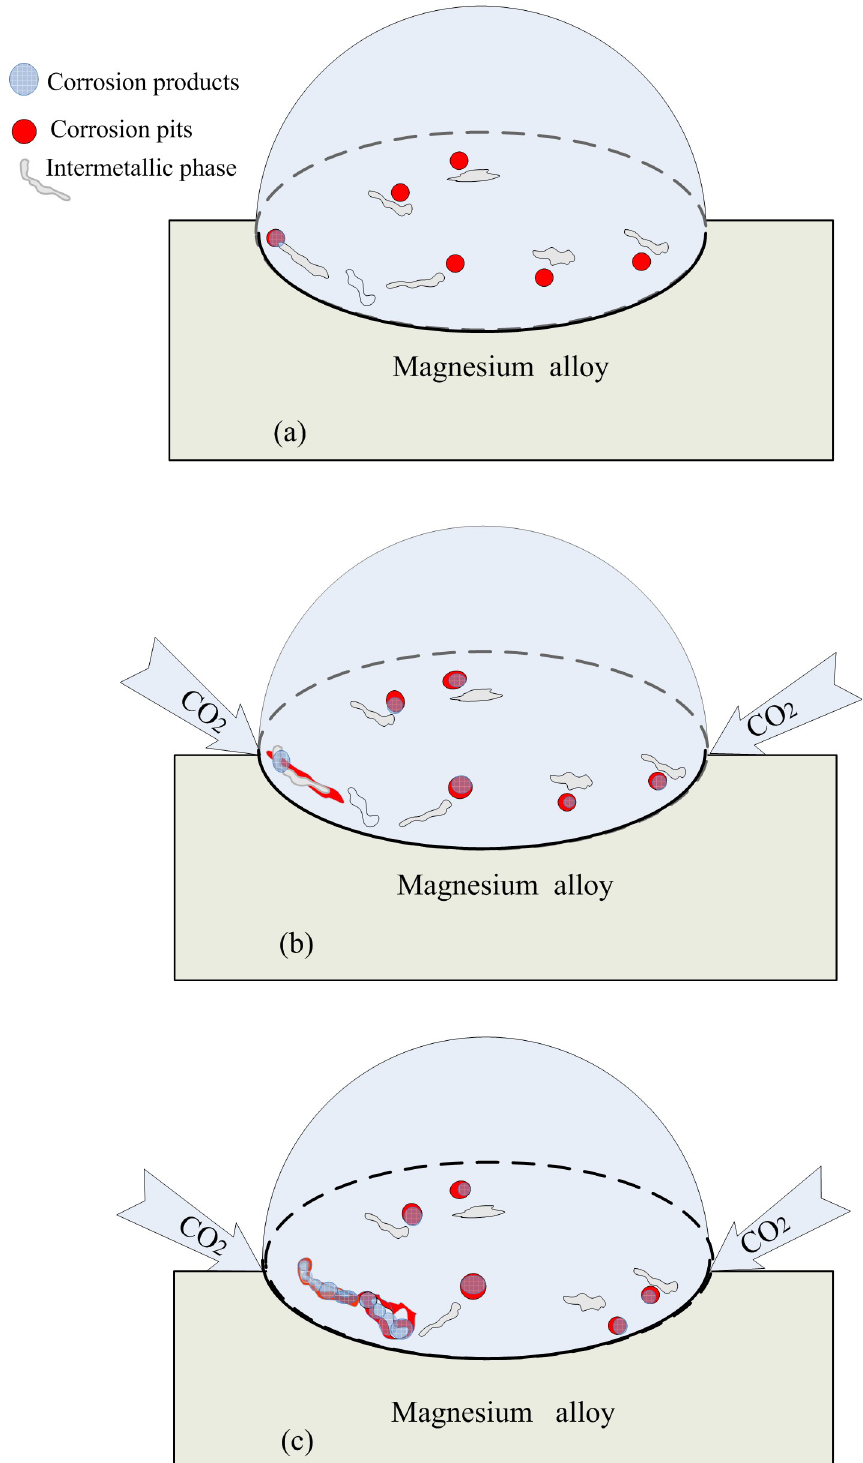
Fig 10. Schematic illustration of corrosion mechanism for Mg alloys under a heterogeneous electrolyte layer.